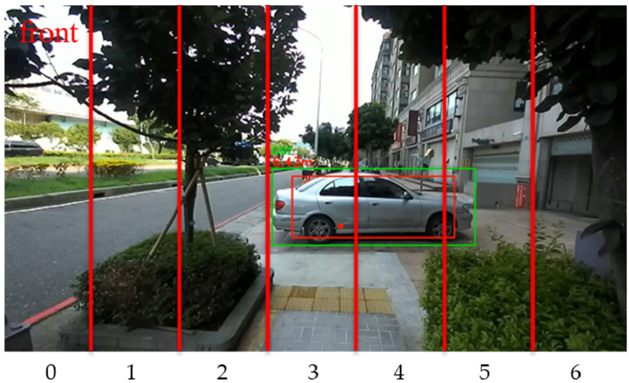
Figure 11. The car appears in the third and fourth divisions from the right.